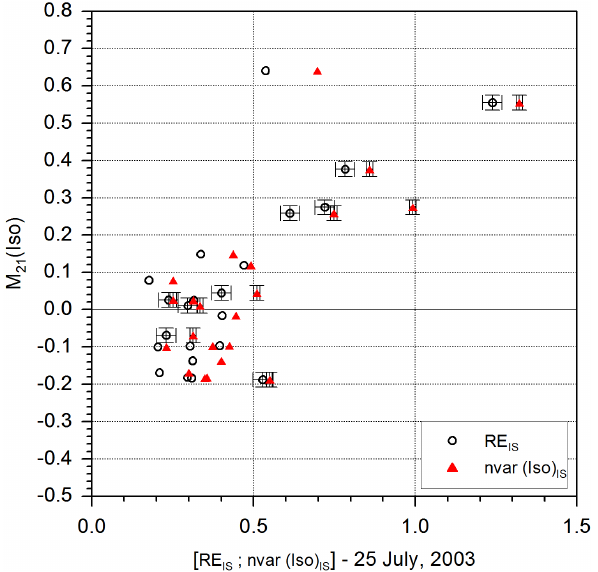
Figure 19. The intensity of segregation as a function of